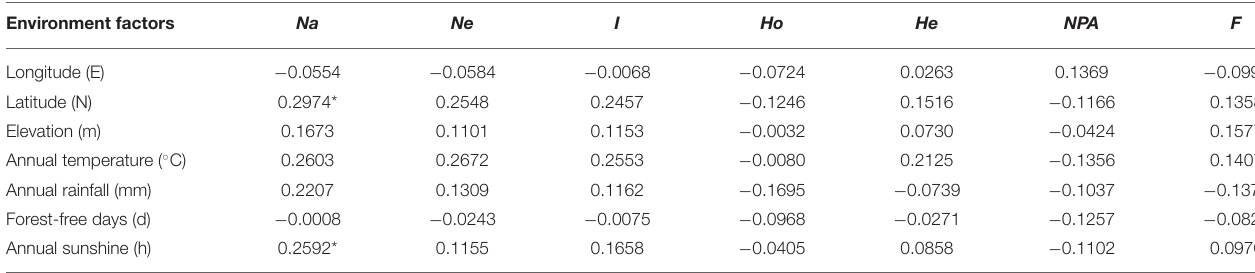
TABLE 6 | Relationship between molecular traits and environmental factors revealed by Mantel